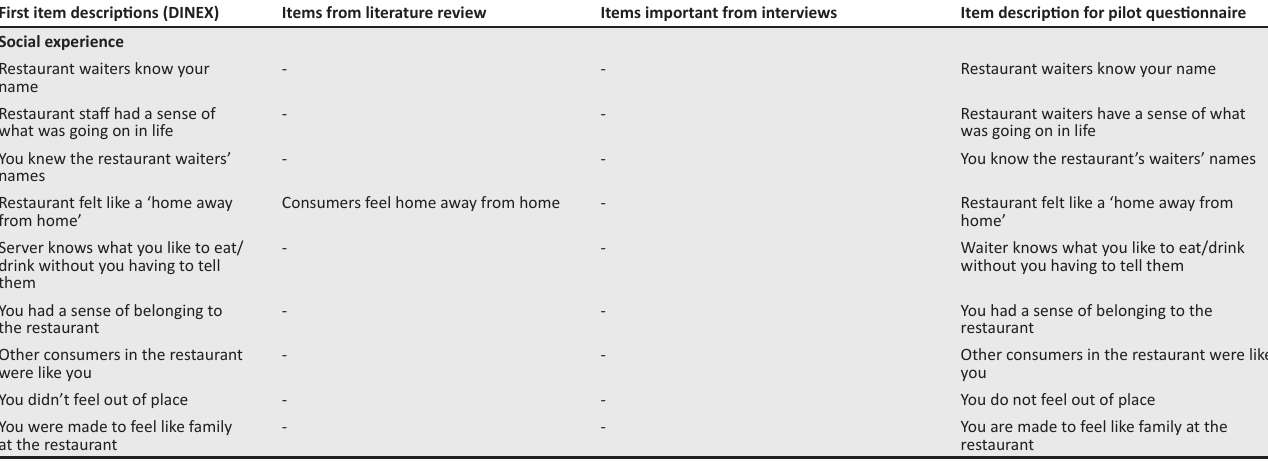
TABLE 1 (Continues...) : Stages of item identification and description of important dining experience dimensions. First item descriptions